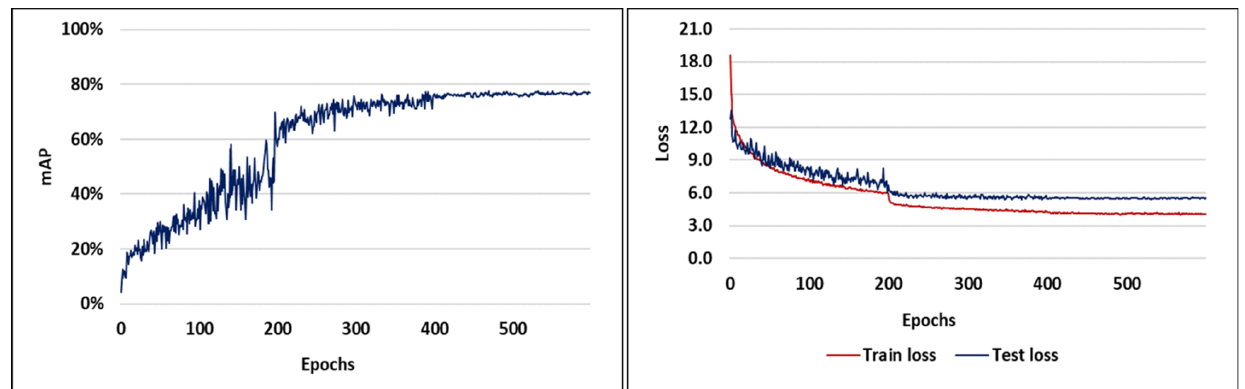
Figure 11. Visual analysis of DETR evaluation indicators during training.